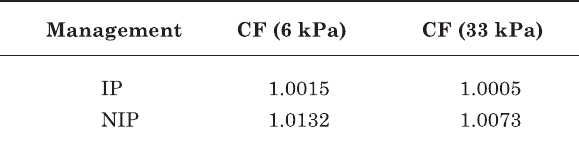
Table 7. Correction factor in different managements and water tensions to calculate the stocking